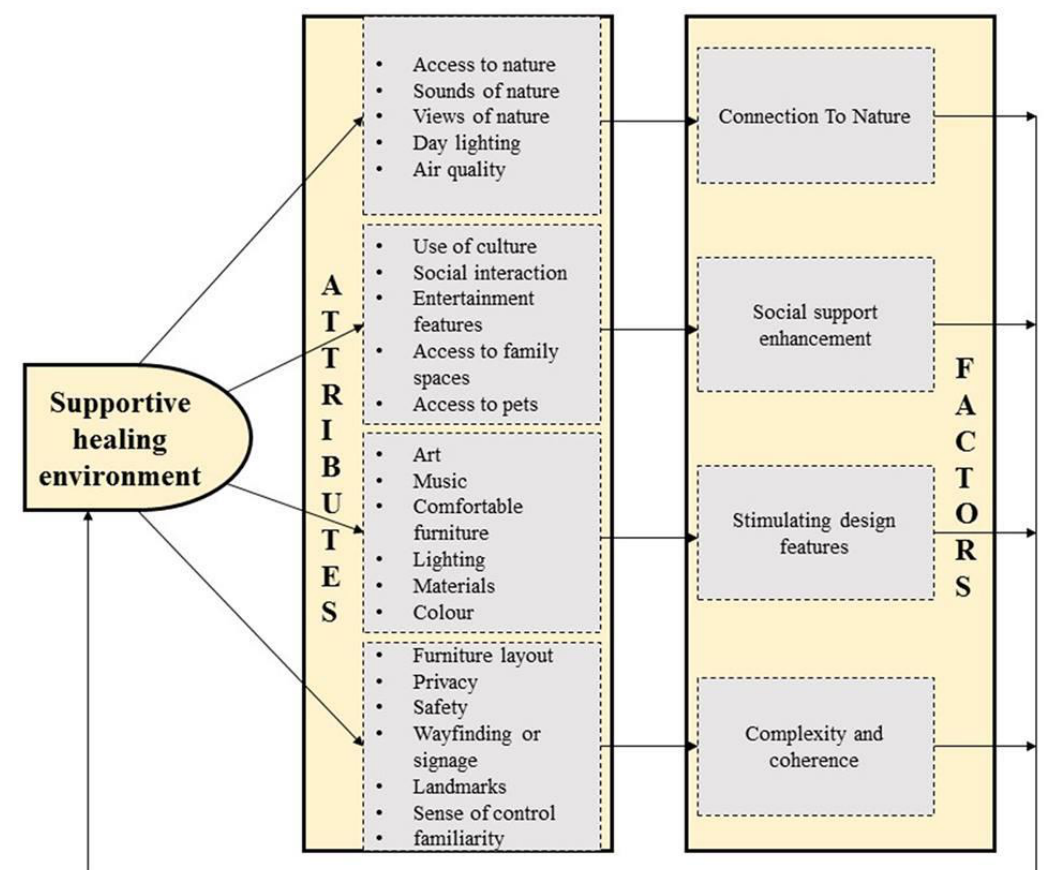
Figure 1. A conceptual model of supportive healing environment with the four attributes from Ul rich’s and Dilani’s theories.